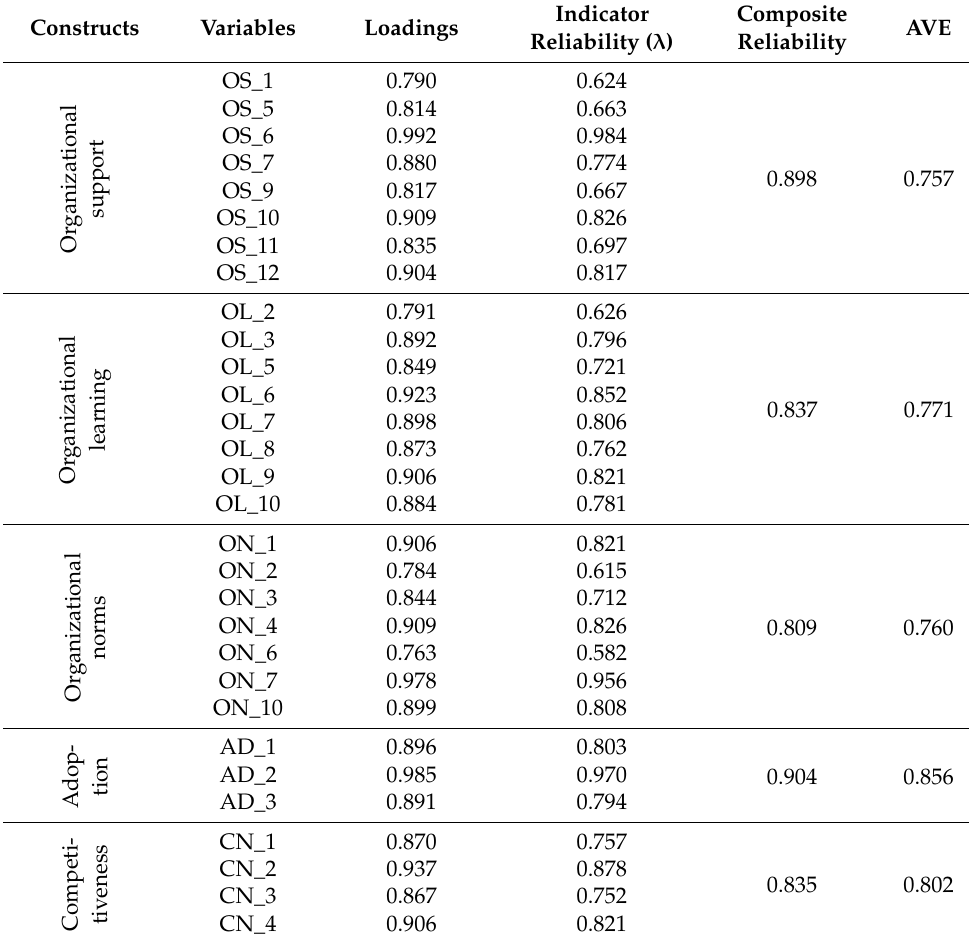
Table 2. Validity of constructs (reflective outer